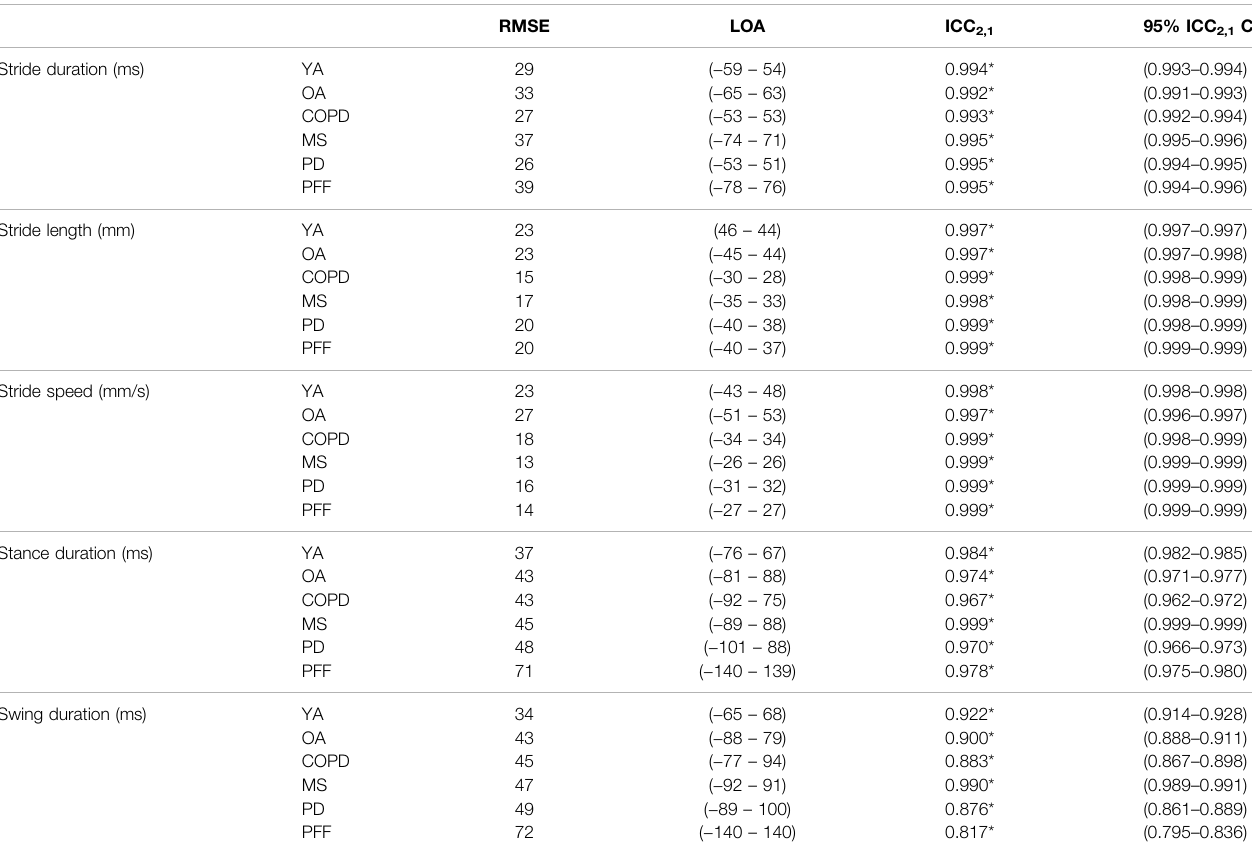
TABLE5| Foreachstrideparameter(strideduration,length,speed,andstance/swingduration)andcohort(younghealthyadults(YA),olderadults(OA),chronicobstructive pulmonary disease (COPD), multiple sclerosis (MS), Parkinson disease (PD), and proximal femur fracture (PFF), root mean square error (RMSE) values, limits of agreement (LOA), ICC 2,1 with its 95% con fi dence interval (CI) are